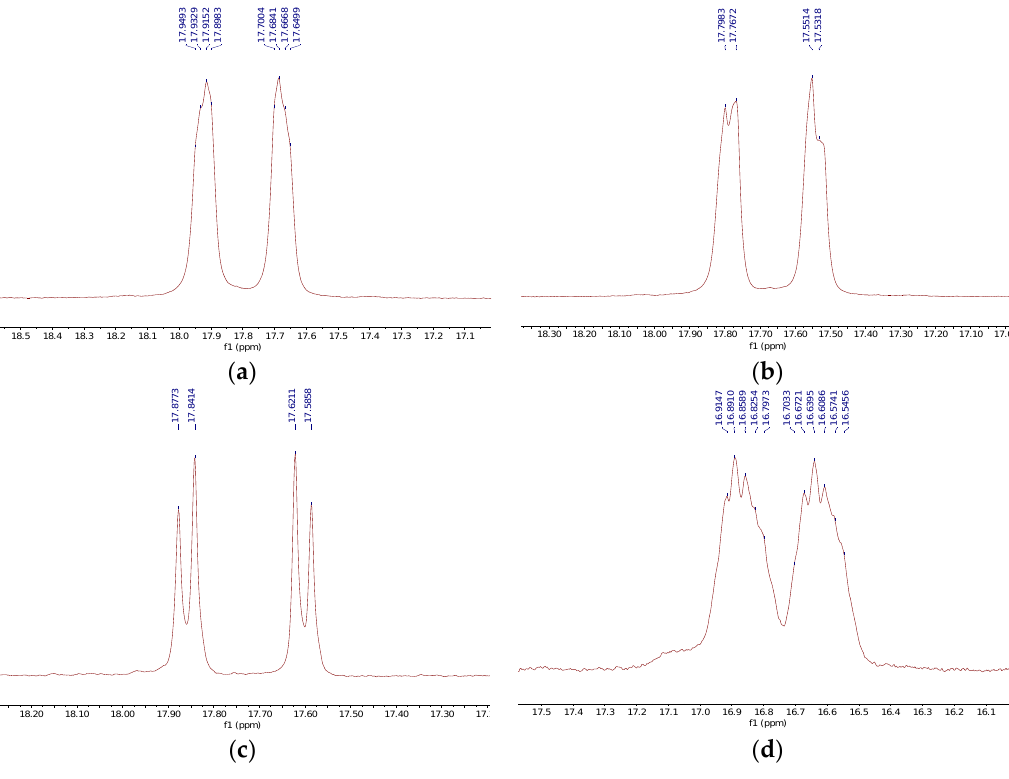
Figure 5. Phosphorus NMR spectra of isomers of (1 S ,2 S ) - 8 ( a ), (1 R ,2 R ) - 8 ( b ), (±) - trans - 8 ( c ), and rac - 8 ( d ).